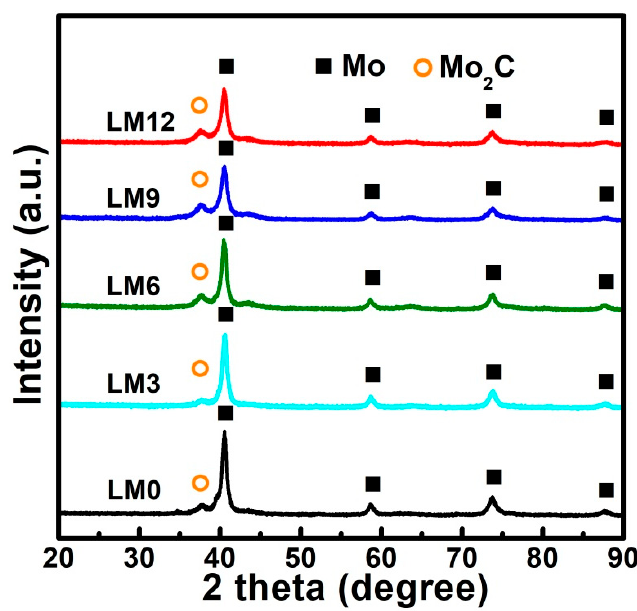
Figure 6. XRD patterns of products reduced by the direct H 2 reduction process.